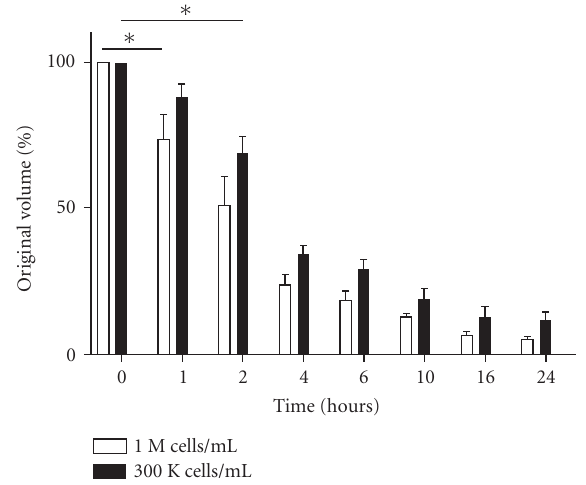
Figure 5: Collagen I hydrogels compact as a function of cellular density. The diameter of the collagen I gels at each time point was measured using Image J and plotted as a percentage of the original volume. Changes in cellular density resulted in significant changes in compaction over the observed 24 hours time course, where an increase in cell density correlated with an increase in gel